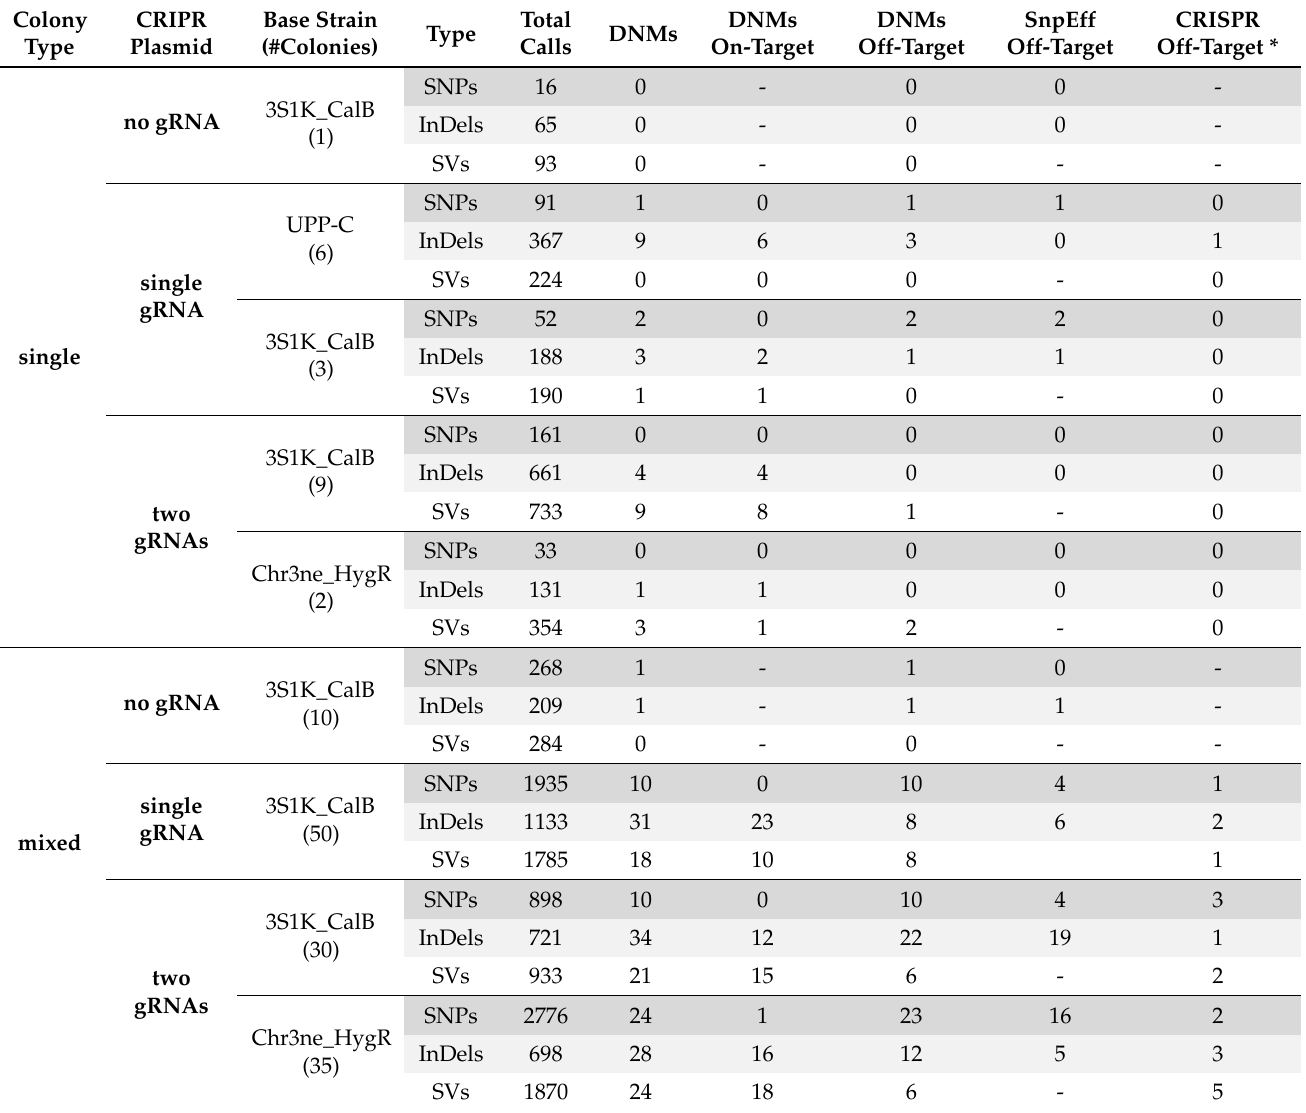
Table 2. Numbers of called variants, showing total calls, which include all called variants compared to the reference including variants already present in the base strain, versus candidate de novo mutations (DNMs), which only include filtered variants likely to have happened during or after transformation of the platform strain. DNMs were further separated into on-target and off-target mutations. SnpEff off-target calls are reduced to variants classified by SnpEff to be within an open reading frame. Potential CRISPR/Cas9 off-target sites include sites with up to 10 mismatches from the used gRNA. The colony type describes if the sequencing was performed on a single colony or on a mixture of 5 colonies. The base strains relate to BSYBG10_3S1K_CalB, BSYBG10_chr3ne_HygR, and UPP-C (3S1K_CalB, chr3n3_HygR and UPP-C) and “#colonies” denotes the total number of colonies included in each